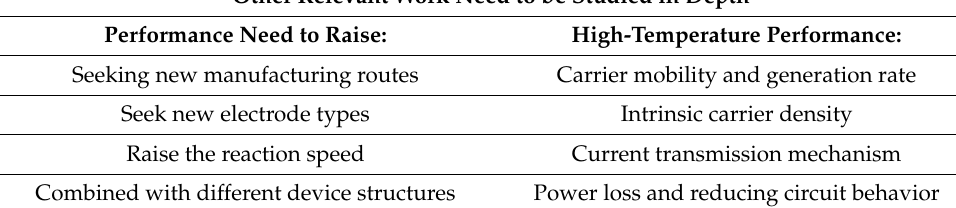
Table 1. The related efforts of optoelectronic performance of non-metallic oxide/diamond pn het- erostructures that need to be explored in